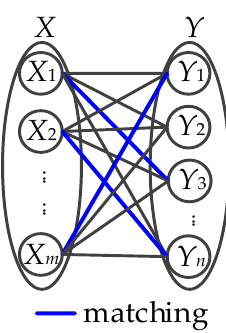
Figure 2. Schematic diagram of two-sided matching.